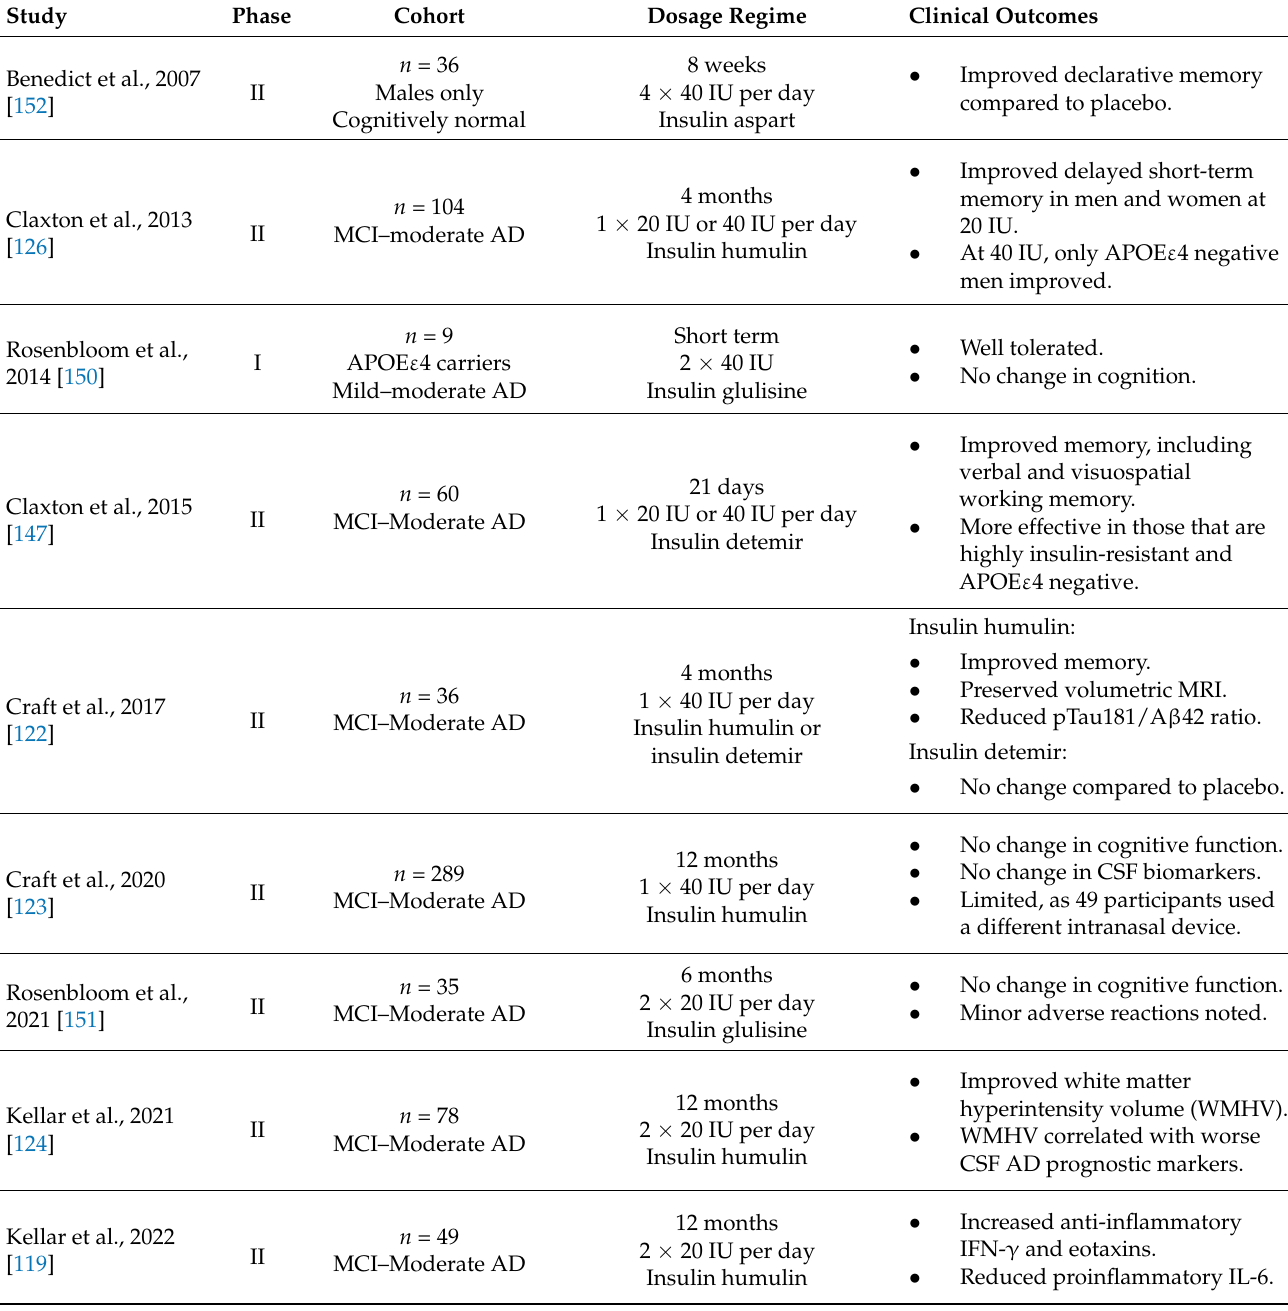
Table 2. Human clinical trial outcomes following intranasal insulin intervention in Alzheimer’s